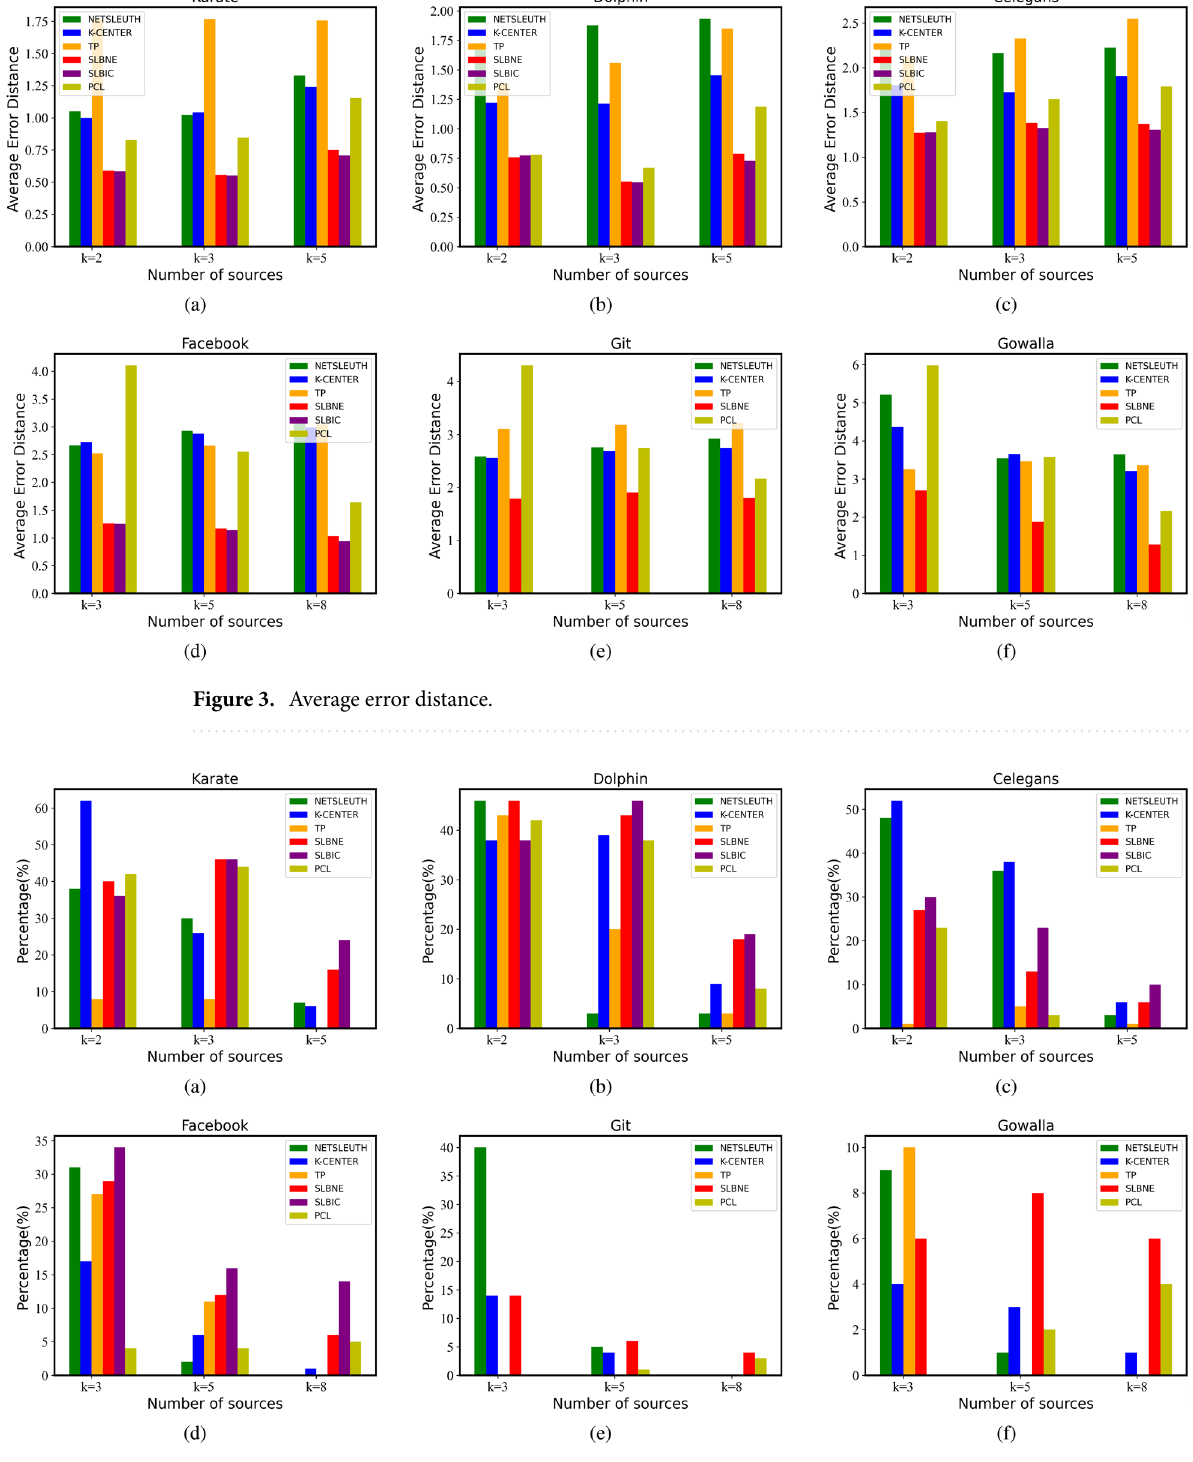
Figure 4. Location accuracy of the number of source